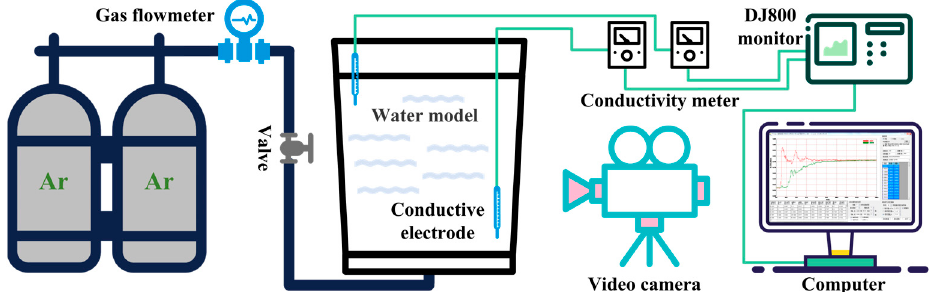
Figure 1. Schematic diagram of water model experimental equipment.